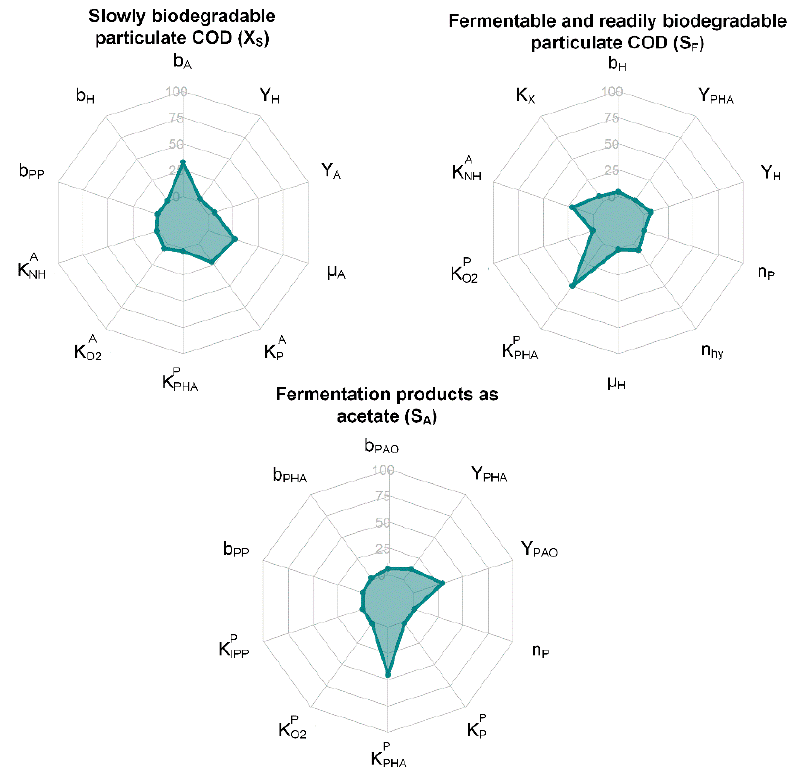
Figure 1. Ten most significant parameters influencing the variability of slowly biodegradable particulate COD, fermentable and readily biodegradable soluble COD, and fermentation products as acetate in the activated sludge (AS) systems. The results in the radar graphs are the proportion of sensitivity function ( 𝑠 (cid:3036)(cid:3037) ) for the state variable against the changes of each model parameter over the total sum of sensitivity measures. The description of the influential parameters in the graph can be found in the Supplementary Material F. Supplementary Material